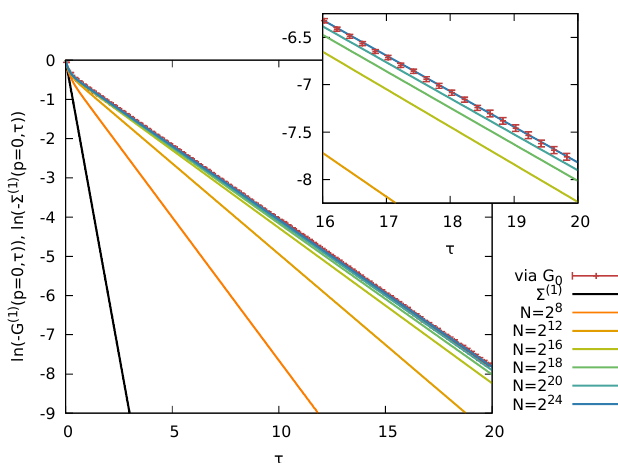
Figure 13: Computation of the Green function G ( 1 ) ( p = 0, τ ) via the first-order self-energy. The result is shown for different number of Matsubara frequencies (powers of 2 are indicated) and compared to the result where G ( 1 ) ( p = 0, τ ) is directly sampled (cf. Sec. 3 with minor modifications: the INSERT update is only allowed on the final electron propagator (which has zero phonon coverage) and REMOVE can only remove the last phonon arc. The SWAP update is disabled). The error bars on the latter correspond (or are smaller than) the line width. The inset shows a zoomed-in version of the last-time region. Error bars on a subset of the data sampled from the bare expansion are shown.